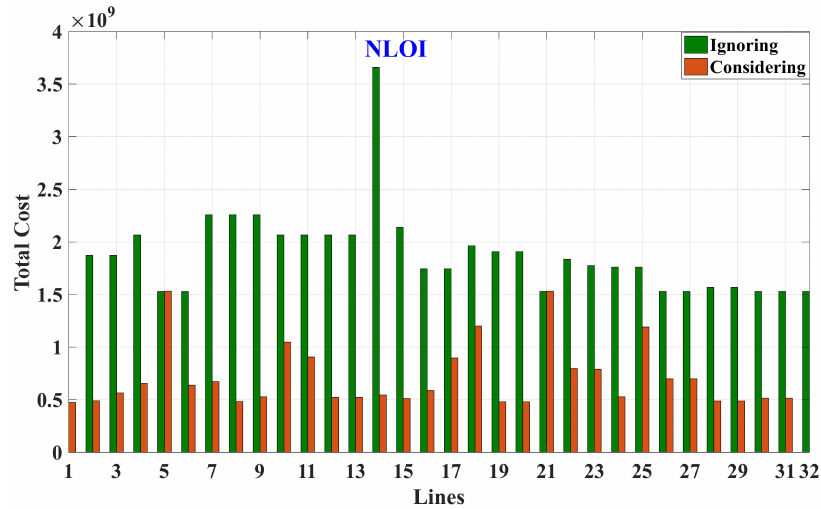
Figure 13. The total cost under the line outage.